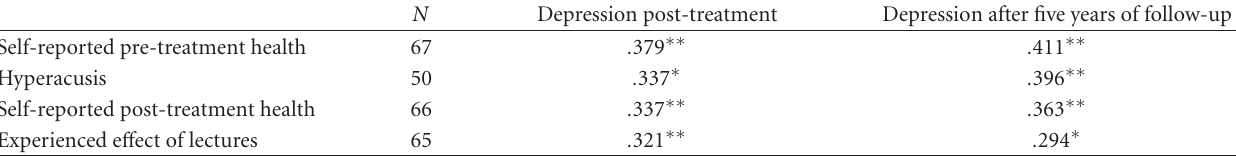
Table 5: Results from bivariate correlation analyses over factors associated with the degree of tinnitus-related depression. N